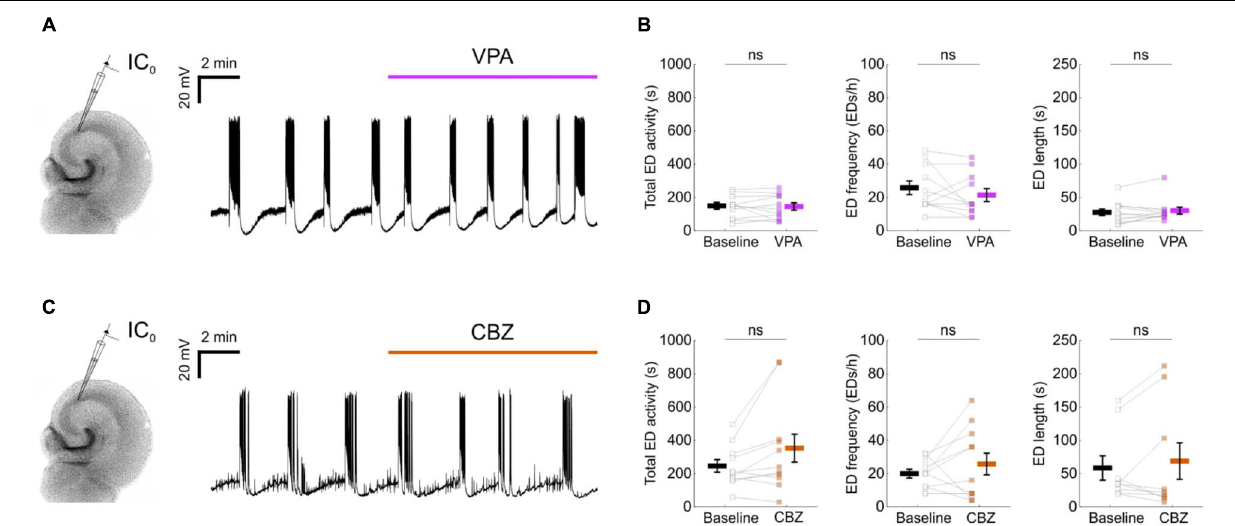
FIGURE 2 | Epileptiform activity in mouse organotypic hippocampal brain slices exhibits resistance to first-line anti-epileptic drugs. (A) A representative recording showing that 1.5 mM valproic acid (VPA) did not disrupt the spontaneous EDs. (B) No impact could be detected of VPA on the total ED activity [left, 146.6 ± 20.4 s during baseline and 142.6 ± 22 s during VPA; N = 11, t ( 10 ) = 0.31, p = 0.7643, two-tailed paired t -test], frequency [middle, 25.5 ± 4 EDs/h during baseline and 21.1 ± 3.9 EDs/h during VPA; N = 11, t ( 10 ) = 1.17, p = 0.2674, two-tailed paired t -test] or individual ED length [right, 27 ± 5 s during baseline and 29.5 ± 5.2 s during VPA; N = 11, W ( 11 ) = 22, p = 0.3652, two-tailed Wilcoxon signed-rank test]. (C) A representative recording showing that 50 µ M carbamazepine (CBZ) did not disrupt the spontaneous EDs. (D) No impact could be detected of CBZ on the total ED activity [left, 242.7 ± 37.8 s during baseline and 350.3 ± 84.2 s during CBZ; N = 11, t ( 10 ) = 2.136, p = 0.0584, two-tailed paired t -test], frequency [middle, 19.6 ± 2.7 EDs/h during baseline and 25.5 ± 6.5 EDs/h during CBZ; N = 11, t ( 10 ) = 1.03, p = 0.3266, two-tailed paired t -test] or individual ED length [right, 57.8 ± 18.3 s during baseline and 68.1 ± 27.4 s during CBZ; N = 9, W ( 9 ) = 21, p = 0.9102, two-tailed Wilcoxon signed-rank test]. VPA and CBZ drug concentrations were equivalent to effective doses in vivo (Albus et al.,